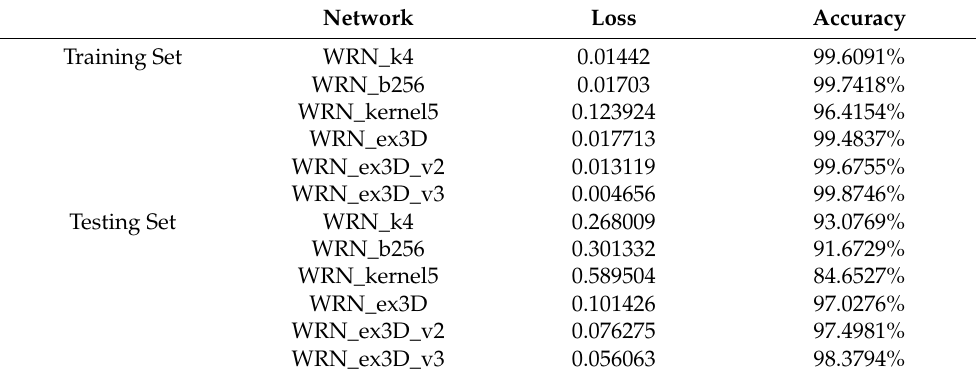
Table 8. Testing results under the condition where the samples were randomly distributed between training and testing sets at a 5:5